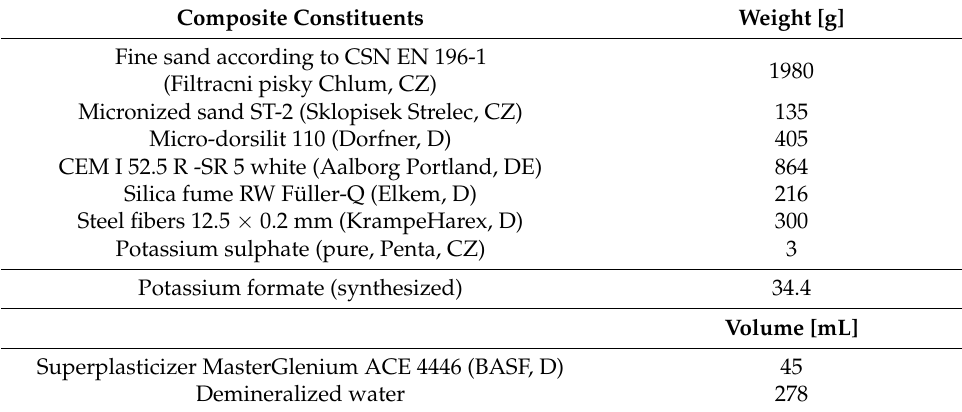
Table 3. Raw materials used for composite